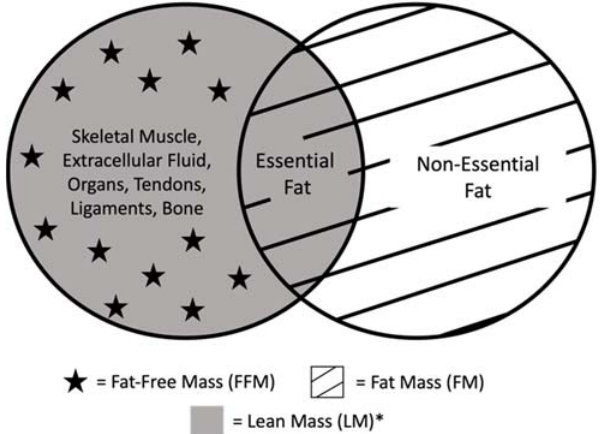
Figure 1. Breakdown of total body composition and definitions. Essential fat includes fat within the bone marrow and organs. Non-essential fat, or storage fat, includes fat surrounding organs and fat located subcutaneously. Within the research, the definitions of lean mass and fat-free mass frequently cause confusion. Some authors exclude bone in the definition of lean mass, and other authors equate lean mass with fat-free mass [9–11]. * lean mass (kg)/height (m 2